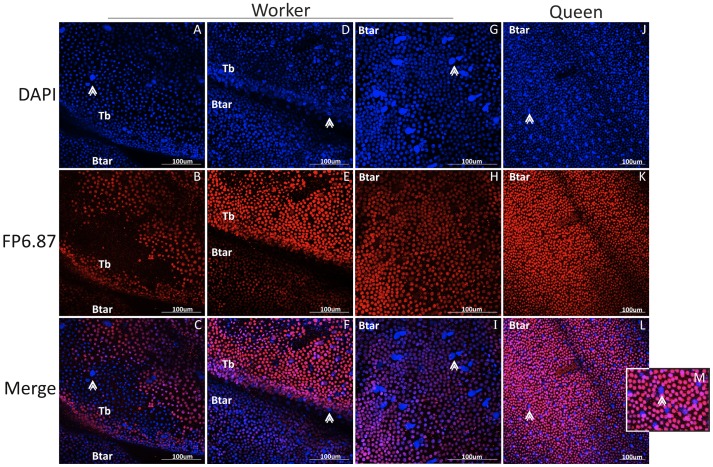
Immunolocalization of Ubx (FP6.87 antibody) in honeybee white-eyed pupale hind legs.
A-C: Ubx is expressed in the tibia and basitarsi of workers. There is a region in the tibia (which may be the future corbicula) that does not express Ubx. D-I: In the basitarsus and distal portion of the tibia (arrowhead) in workers, there are double nuclei that do not express Ubx, arranged in a similar pattern as that of the bristles in the adult hind leg. J-L: In the hind legs of queen white-eyed pupae, Ubx is expressed only in the basitarsi. In blue: DAPI; in red: Ubx; Btar: basitarsi; Tb: tibia. Original scale bars of confocal system.